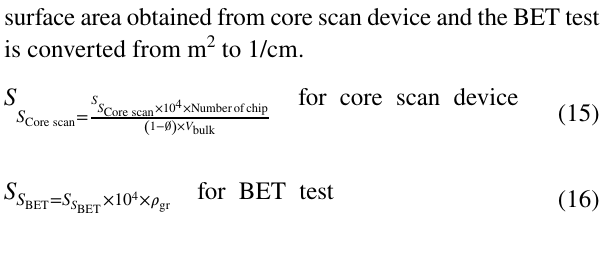
Table 10 Corrected specific surface area and porosity of selected chips Sample Selected chips Corrected specific surface area of selected chips